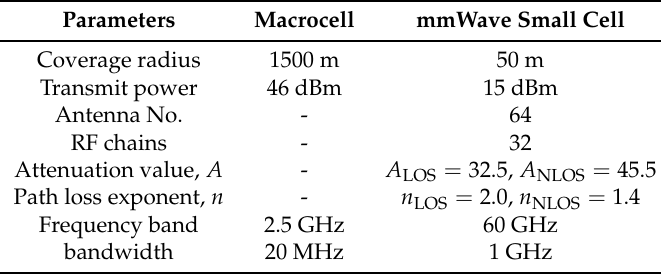
Table 1. Simulation parameters No. 1.